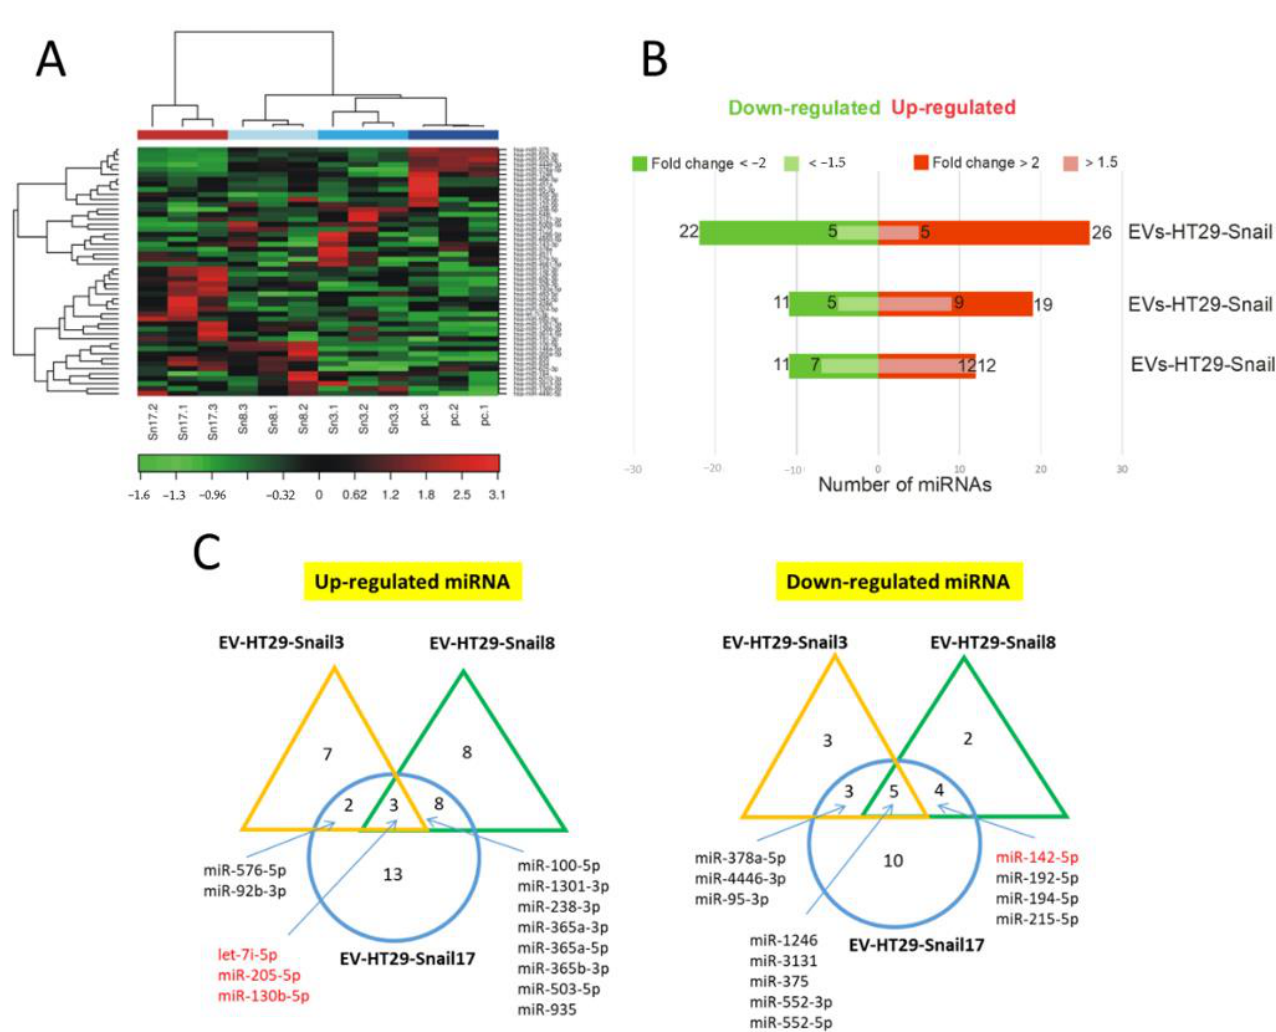
Figure 2. Changes in the expression of miRNAs in EVs released by HT29-Snail cells as compared to EVs from HT29-pcDNA cells. ( A ) Heatmap and unsupervised hierarchical clustering by sample and miRNA. ( B ) Number of differentially expressed miRNAs detected by NGS analysis, that were either significantly upregulated (red) or downregulated (green) in EVs derived from HT29-Snail-3, -8 and -17 versus EVs from control cells. ( C ) Venn diagrams show differentially expressed miRNAs. The most regulated miRNAs in all three or two clone-EVs are marked. (corrected FDR p < 0.05 and fold change > 2). miRs marked in red are discussed in the text.